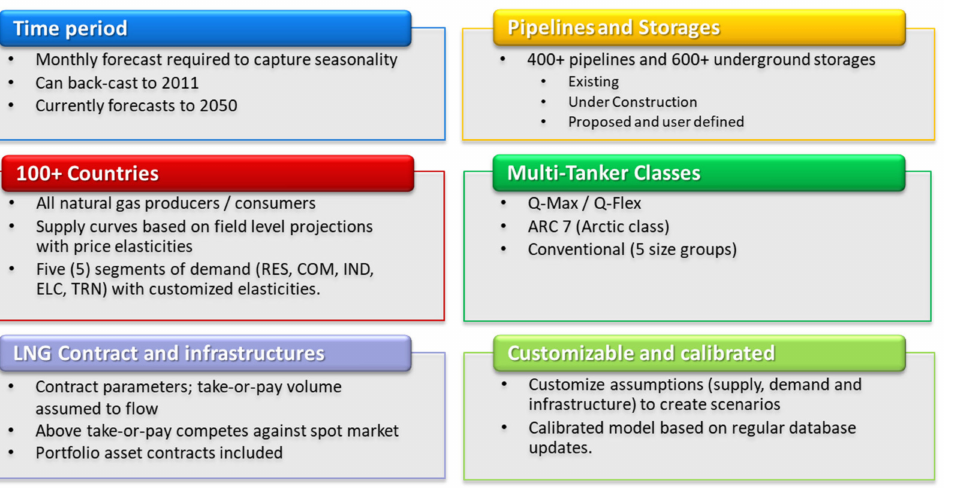
Figure 10. G2M2 ® data and scope.